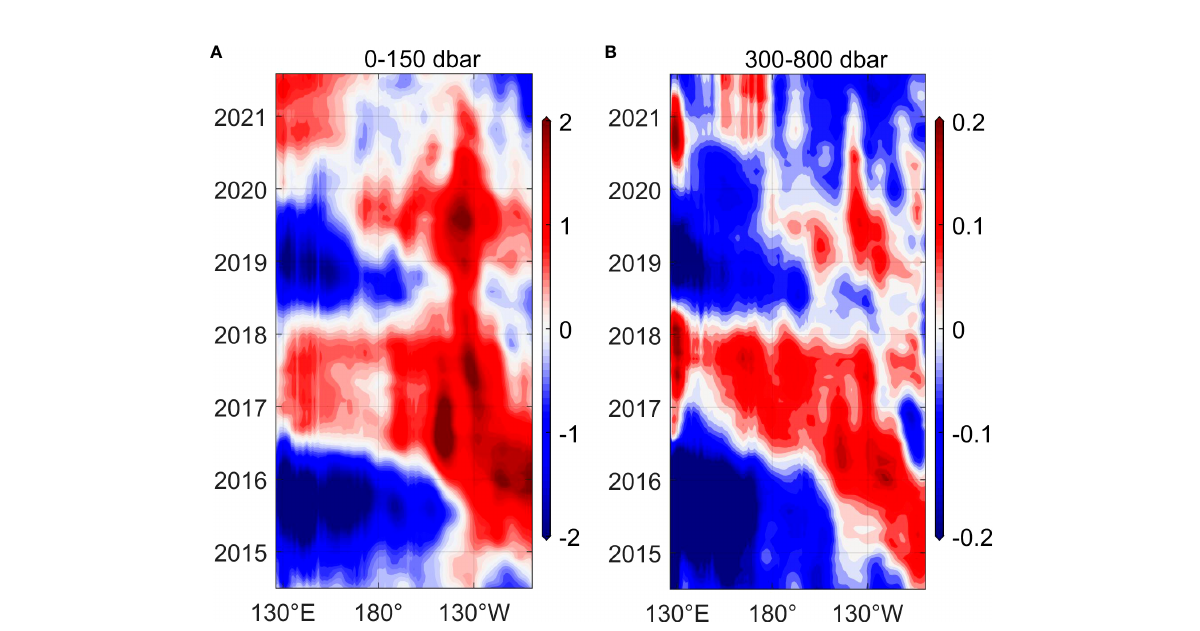
FIGURE 13 Hovmöller diagram of the temperature anomaly (°C) averaged between (A) 0-150 dbar and (B) 300-800 dbar at 8.5°N derived from Argo during 2014-2021. Note that the colorbar scale is different in (A) and (B)